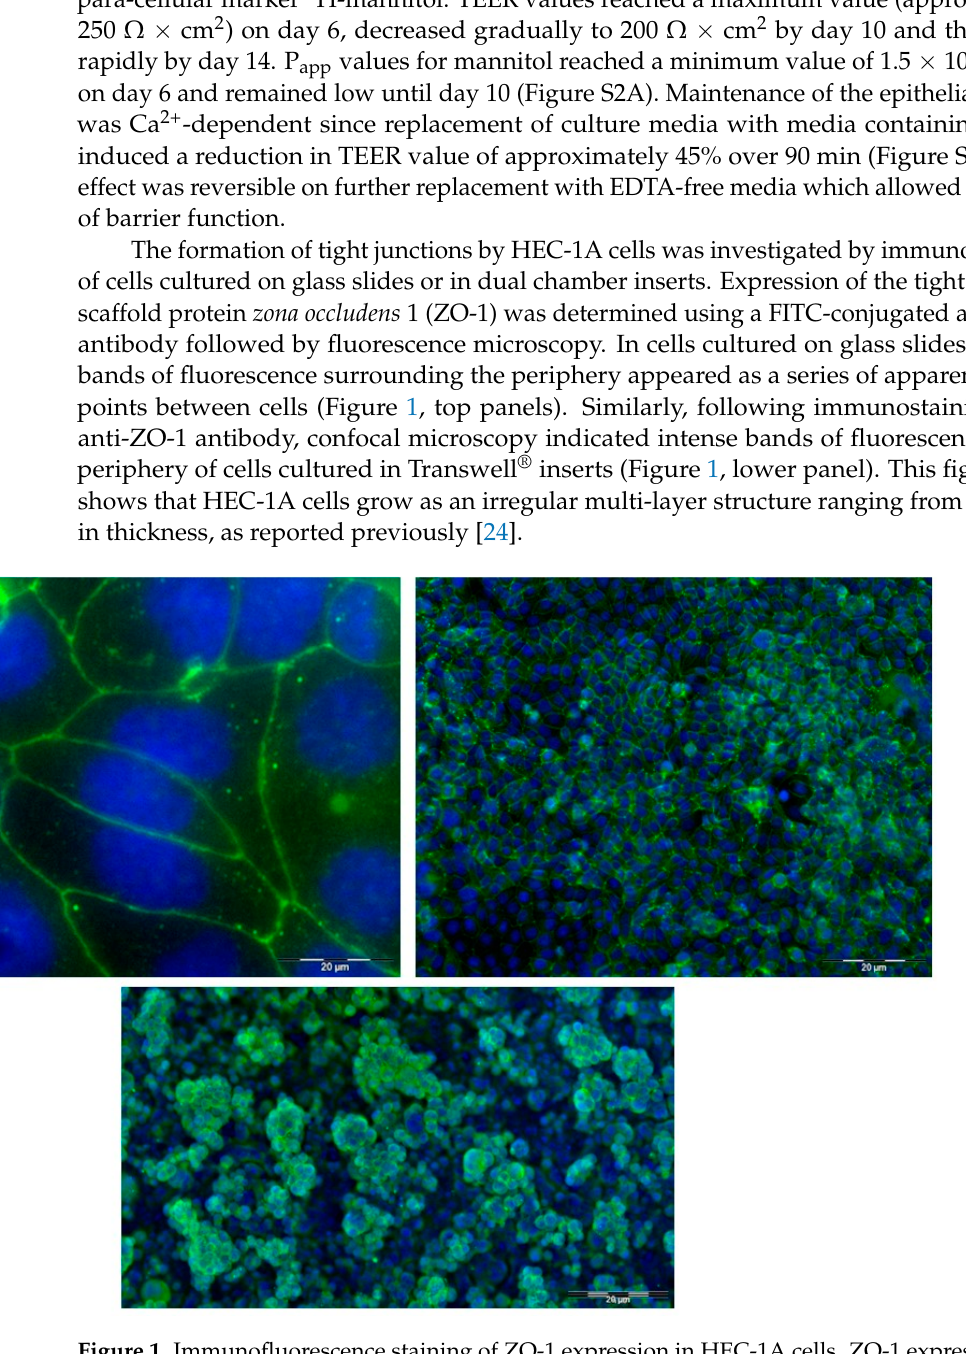
Figure 1. Immunofluorescence staining of ZO-1 expression in HEC-1A cells. ZO-1 expression was visualised using a mouse IgG1 FITC-conjugated monoclonal antibody to the ZO-1 tight junction protein (green), and cell nuclei were stained with Dapi (blue). Merge images were produced of cell nuclei and tight junction staining at 10× and 60× magnifications for cells grown on glass slides for five days ( top panels ) and HEC-1A cell layers cultured for 7 days on polyester Transwells ® ( lower panel ). Scale bar for all images in 20 μ m.